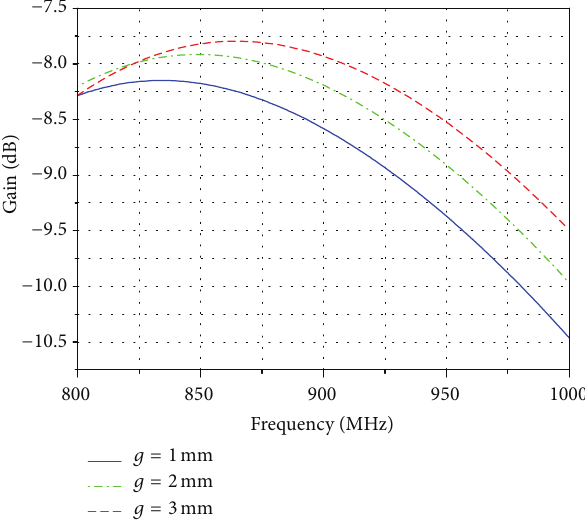
Figure 6: Antenna gain for different sizes of the